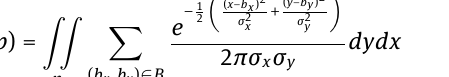
Table 1: Comparative recognition results of images from a database of 20 classes of textures by the method of the persistent images and persistent landscapes Class Classification of number of textures by textures persistent images. Proportion of recognition in each class in %